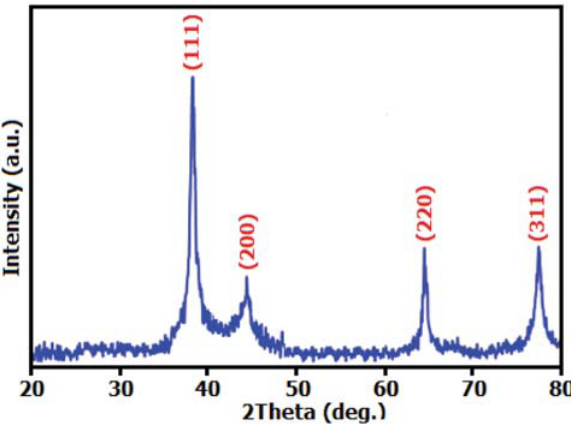
Figure 4. XRD pattern of Ag NPs synthesized by Date fruit